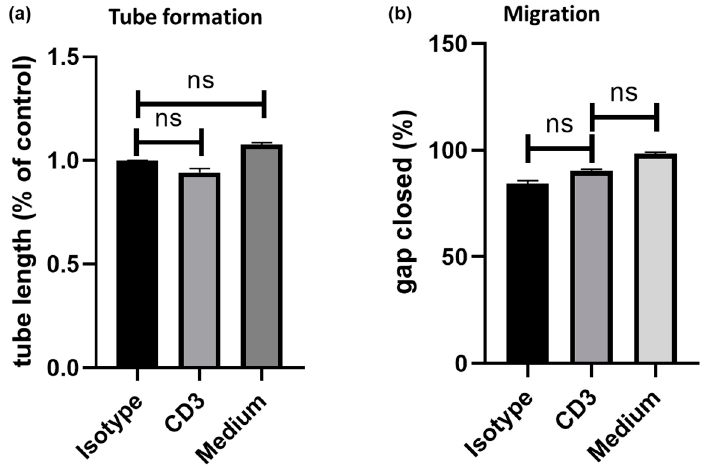
Figure 3. human umbilical vein endothelial cell (HUVECs) were exposed to anti-CD3 treated PBMCs. Cell migration and angiogenesis were assessed by ( a ) tube assay and ( b ) tube formation, respectively. Compared to isotype control (100%), exposure to supernatant of anti-CD3 treated PBMC did not induce ( a ) endothelial cell tube formation (94 ± 2%; p = n.s. versus isotype control) ( b ) nor chemotaxis (90 ± 1%; p = n.s.) in HUVECs.